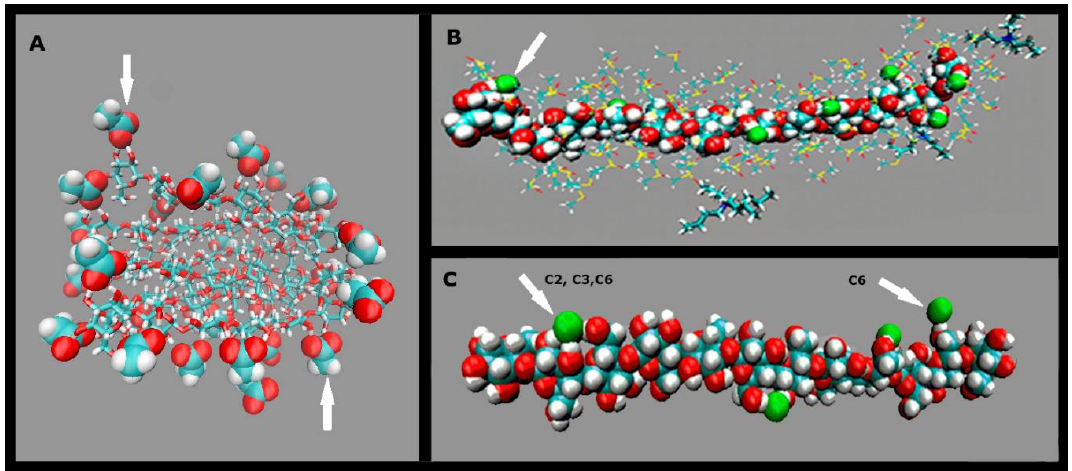
Figure 10. Molecular dynamic-based snapshots for the dissolution of cellulose oligomers by in IL-DMSO. Parts ( A – C ) are for the following ILs, respectively: diallylbenzylmethylammonium acetate (unpublished data), tetra( n -butyl)ammonium fluoride (TBAF), 1-allyl-3-methylimidazolium chloride (AlMeImCl); adapted from [73,84], with permission from Elsevier, 2014 and 2015.